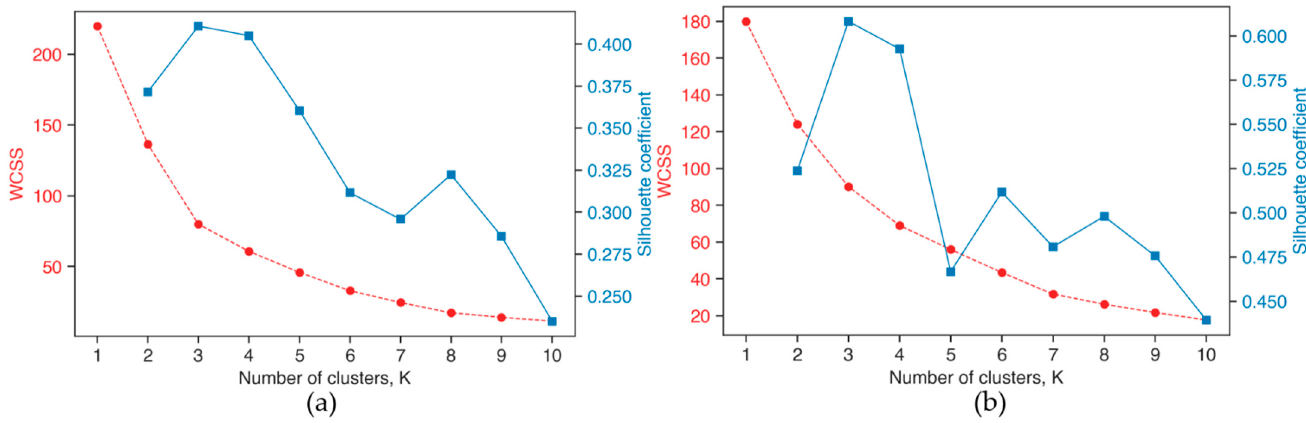
Figure 2. Metrics to determine the optimum number of clusters for ( a ) dataset 1 and ( b ) dataset 2. Within-cluster sum of squares (WCSS) is denoted by the red circles and dashed line. Silhouette coefficients are denoted by blue squares and solid line.